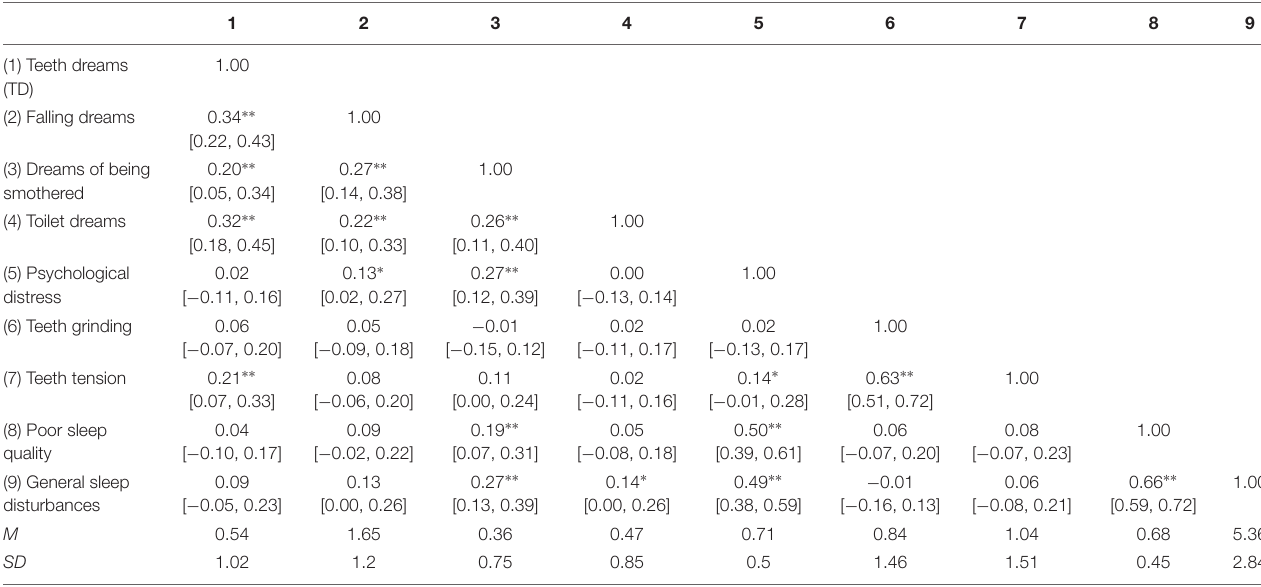
TABLE 1 | Means, standard deviations, and rank-order correlation coefficients of teeth dreams (TD), falling dreams, dreams of being smothered, toilet dreams, psychological distress, teeth grinding, teeth tension, poor sleep quality, and general sleep disturbances. 1 2